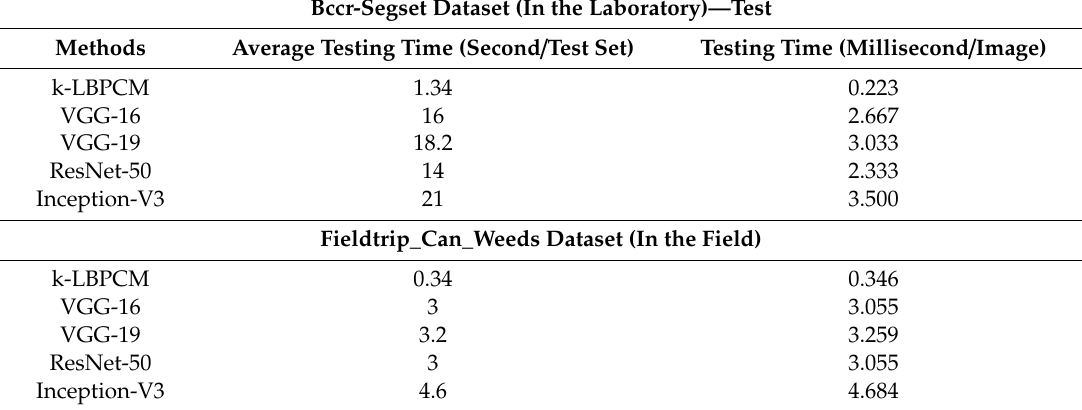
Table 10. Testing time of the k-FLBPCM method and CNNs for the laboratory dataset (6000 images used for the test set) and the field dataset (982 images used for the field test set). Bccr-Segset Dataset (In the